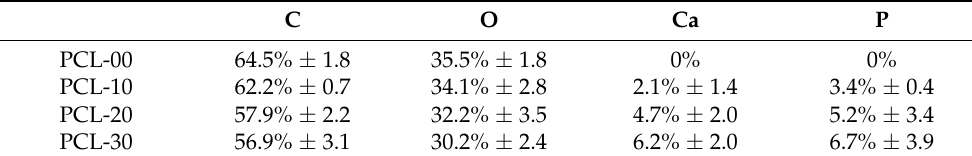
Figure 2. Cross-sectional surface morphology of different PCL/ β -TCP ratio fibers using SEM. β -TCP distribution in PCL fibers is indicated by white arrows. The scale bar indicates 1 mm at 45× , 30 μm at 1500× , and 10 μm at 5000 ×. Table 2. Element distribution of PCL/ β -TCP fibers from EDS analysis. Carbon, C; oxygen, O; calcium, Ca; phosphorous,